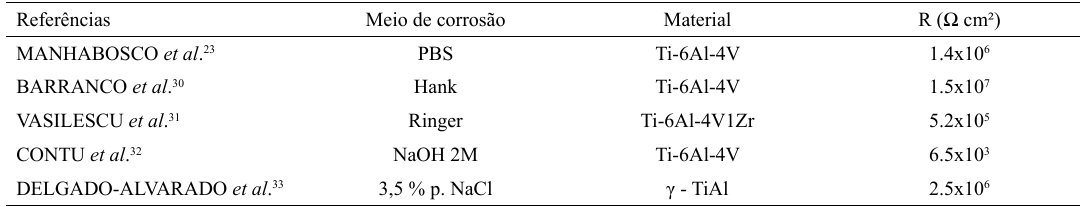
frequencies (f < 10 Hz or f > 100 kHz), the phase angle approaches to 0°. For intermediate frequencies (0.1 <f <100 kHz) the phase angle remains close to -90°, indicating that the system resistance is controlled by surface polarizing of the working electrode. The higher is the range of intermediate frequency values close to -90°, more stable is the passivating film 19,31 . Ti-6Al-4V alloy showed nearly ideal capacitive behavior at the two studied temperatures (Figures 8, 11 and 12). Remaining in broad bands of intermediate frequency with a maximum phase angle close to -90° (at 25 °C ≈ -80°; at 60 °C ≈ -75°); and in log |Z| x log frequency plots, the slope is about -1. The results agree with other previous reports. Kumar et al. 35 and Wang et al. 36 , who study Ti-6Al-4V electrochemical properties found log |Z| x log frequency plots slope close to -1 and the maximum phase angles between -70° and -85°. The n values obtained from the log |Z| x log frequency slope ranged between 0.45 < n < 1.0 and agrees with Grips et al. 37 , Liu et al. 38 and Wan et al. 39 findings. Alloying elements adition in binary nitrides of transition metals, such as Al and Cr, controls micropore size and density, improves the hardness and fracture toughness and increases corrosion and wear resistance 37 . A multilayer coating improves corrosion behavior when compared with a simple coating because of the increased coating thickness, which leads to statistical decrease of defects possibility through structured layers, phases electrochemical potentials will